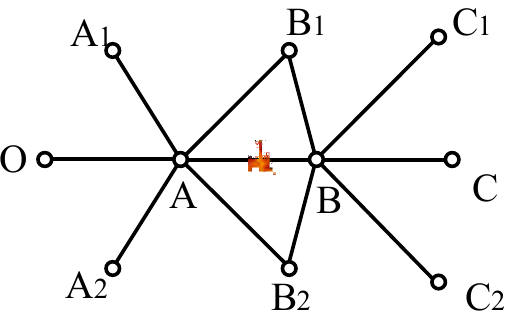
Figure 10. Schematic diagram of the analysis component.